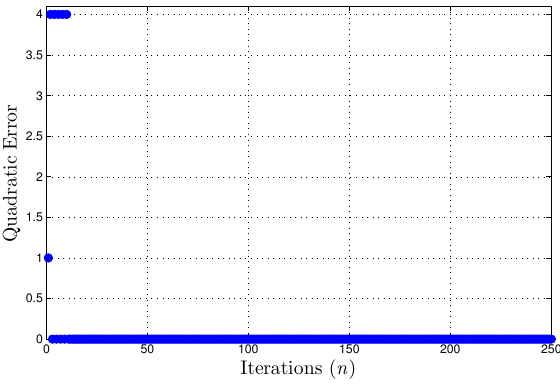
Figure 8. Quadratic error during training using the XOR dataset, fixed point